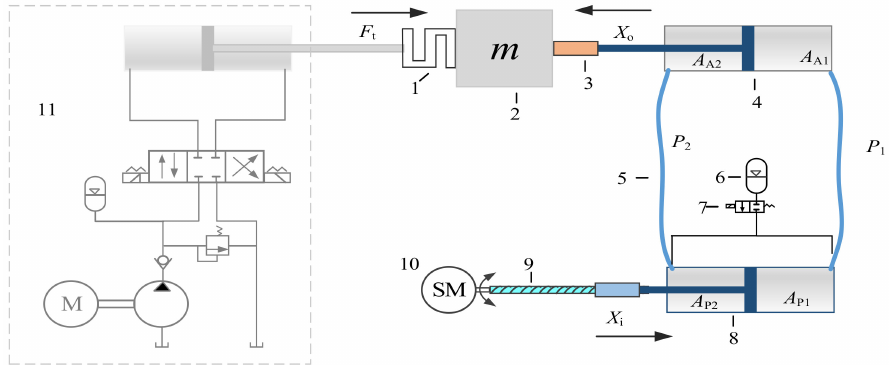
Figure 1. Schematic diagram of the whole system. 1. Force transducer; 2. Load mass; 3. LVDT; 4. Target cylinder; 5. Hose; 6. Accumulator; 7. On / o ff valve; 8. Power cylinder; 9. Ball screw; 10. Stepping motor; 11. Loading